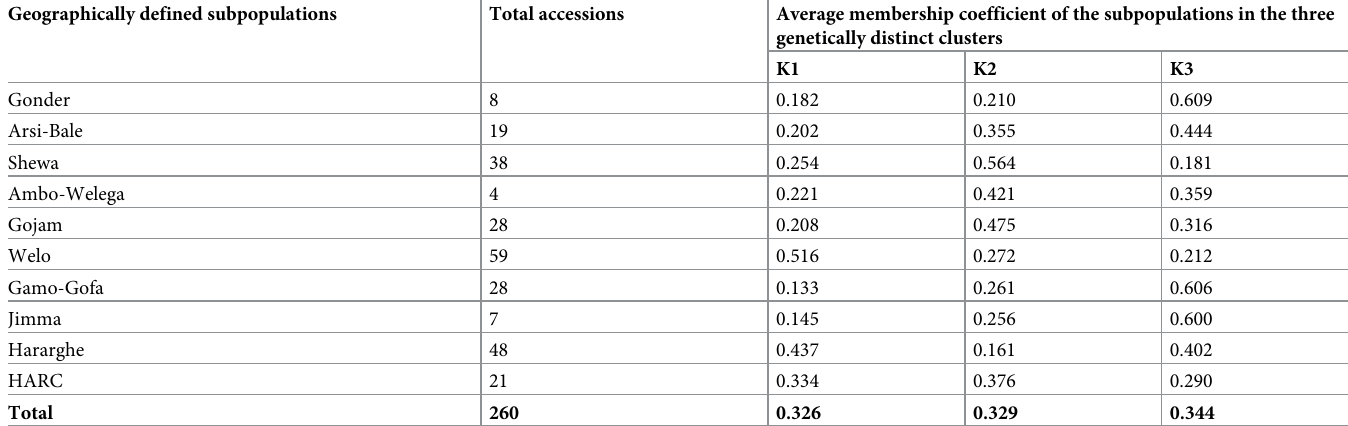
Table 2. Average membership coefficient of Ethiopian geographically defined subpopulations based on the three genetically distinct clusters. Geographically defined subpopulations